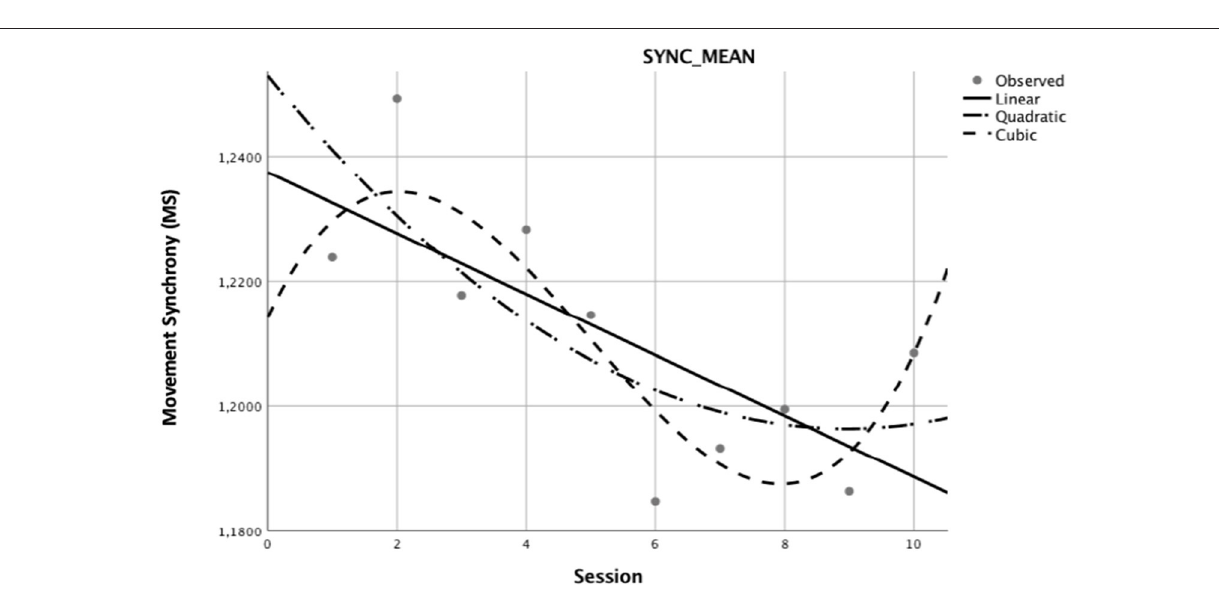
FIGURE 3 | Mean best curve fit related to movement synchrony. Reduced best fitting curves for Mean Synchrony of dyads ( N = 173) that completed coaching sessions represented in linear, quadratic, and cubic curves. The x-axis depicts sessions 1 to 10.The y-axis depicts the index of MS calculated as an expression of the movement coordination between coach and